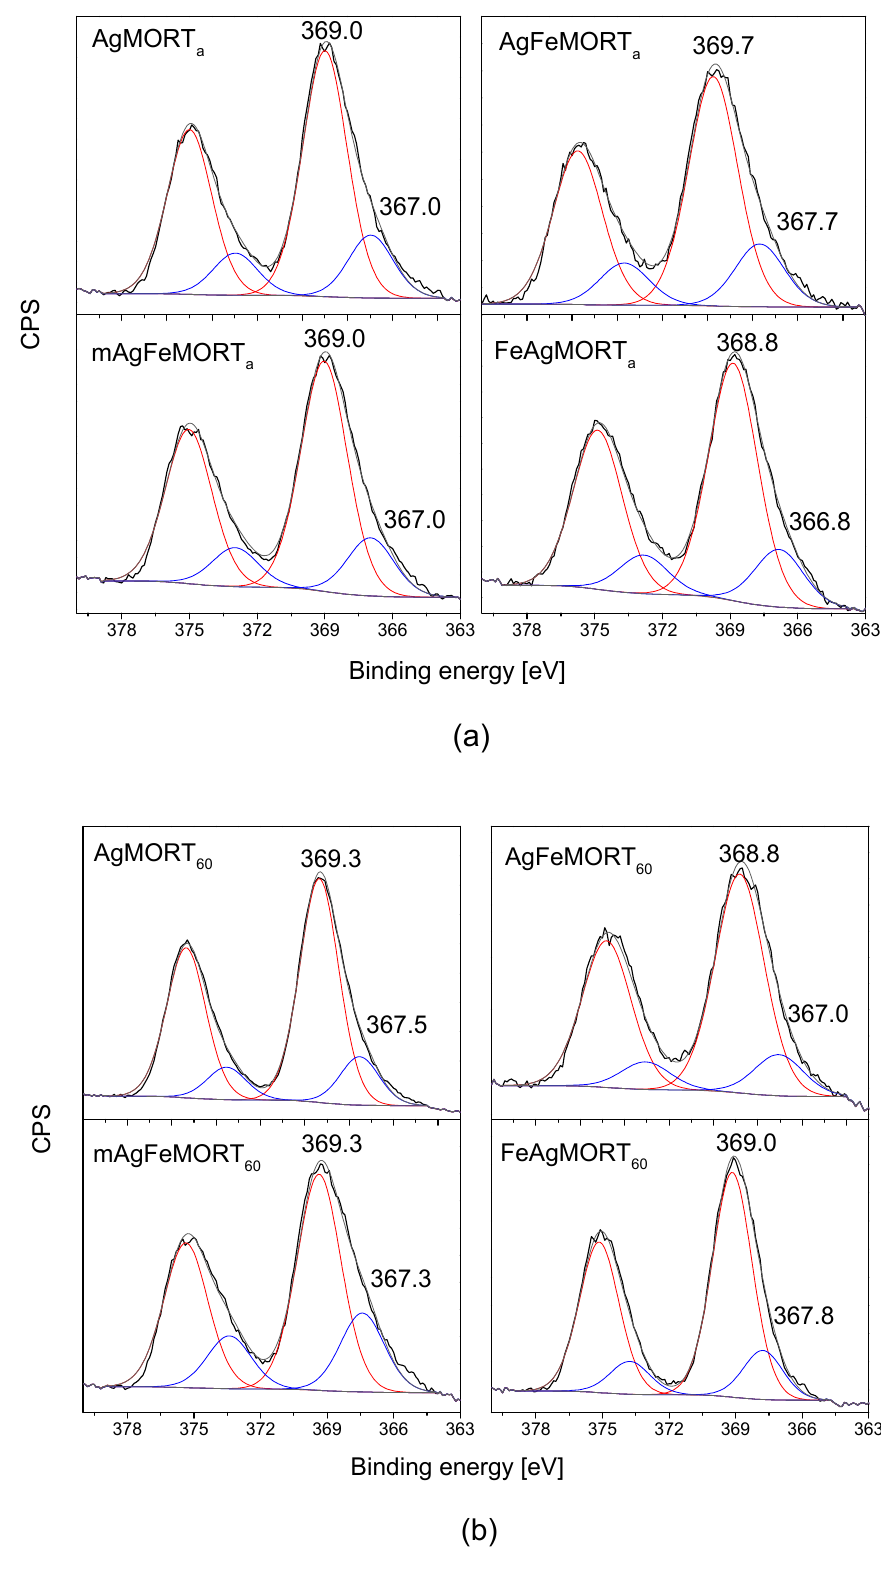
Figure 2. Ag 3d 5/2 photoelectron spectra of mono- and bimetallic samples prepared at: ( a ) room temperature, and ( b ) 60 °C.